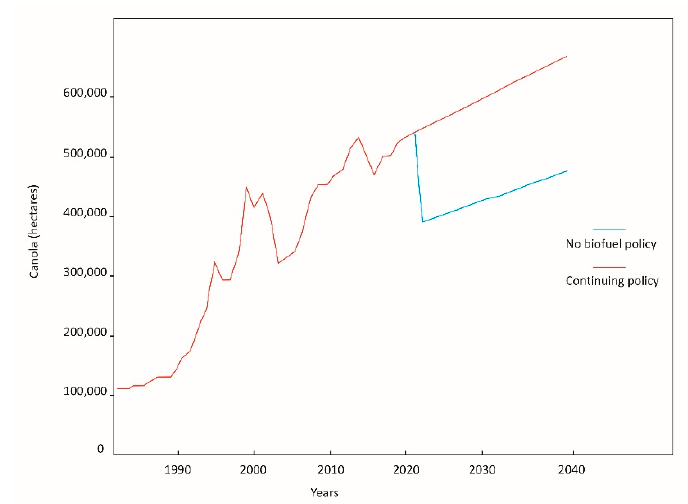
Figure 4. Prediction of canola development in the Czech Republic until 2040.